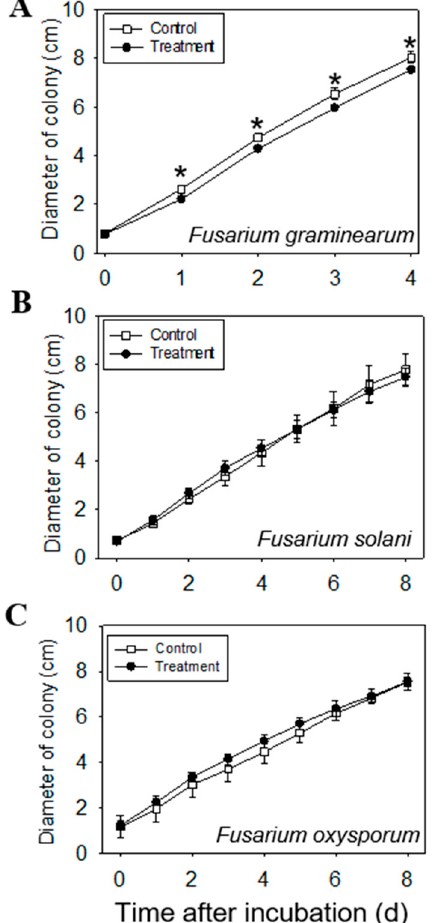
Figure 6. Daily antifungal effect of volatiles from C. iria leaves to Fusarium species until the mycelium reached the edge of the Petri dish: Fusarium graminearum ( A ), Fusarium solani ( B ), Fusarium oxysporum ( C ). * represents a significant difference in volatiles from C. iria leaves between the control and the treatment at P ≤ 0.05 according to a Student’s t -test. Seven replicates of each treatment and three replicates of the control for each fungal species were conducted.